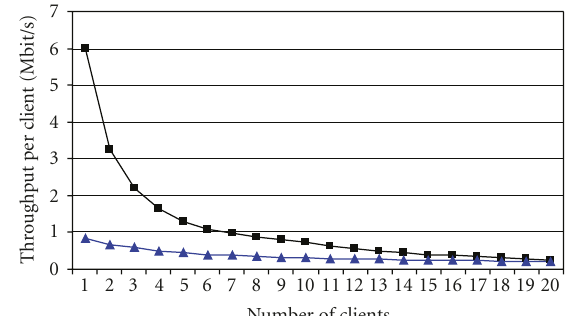
Figure 1: Throughput per client. Top line: All fast nodes. Bottom line: One slow node, all others fast.